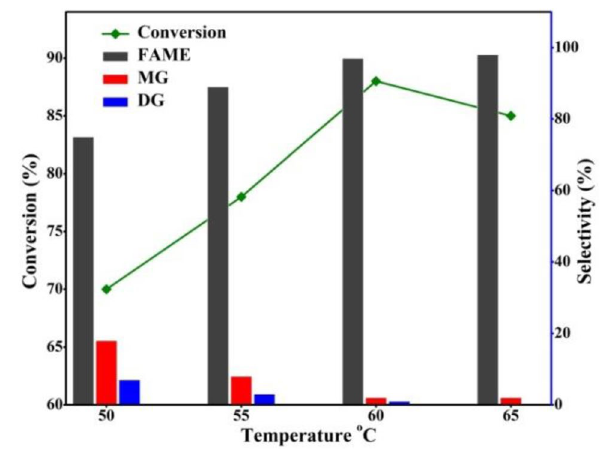
Fig. 10 Effect of reaction temperature over 20% HPWA/KIT-6 in transesterification of neem oil [Reaction condition: catalyst, 0.35 g; oil, 10 g; 50–65 °C; run time, 3 h; MeOH/oil (mole),